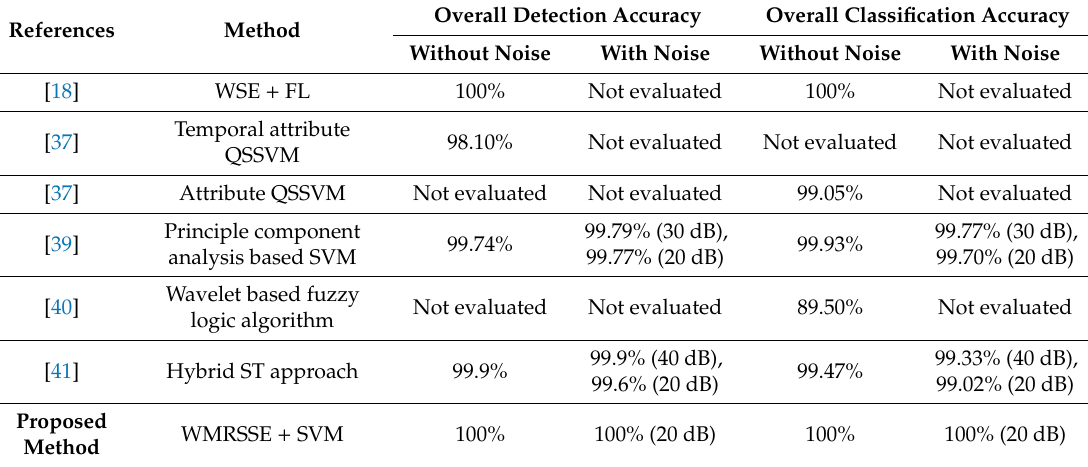
Table 6. Comparison of the performance of the proposed protection scheme with previous related